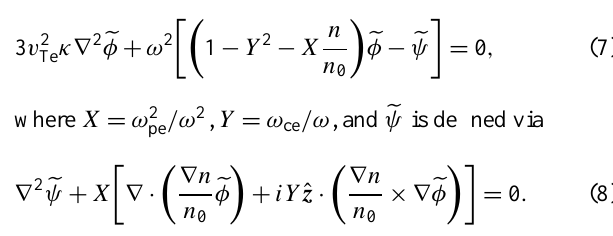
Figure 1. (a) The frequency spectrum of UH oscillations (arbi- trary units) at the center of a deep striation ( α = 0 . 1), obtained from an electrostatic simulation using a short driving pulse at the begin- ning of the simulation to excite oscillations. (b–c) : resonances indi- cated by circles, showing the eigenfrequencies ω and azimuthal- mode numbers N for (b) the coupled Eqs. (9)–(10), and (c) the Schrödinger equation (13). For each azimuthal-mode number, there exist one or more radial modes enumerated by the mode number R with R = 1 having the lowest frequency. Small azimuthal-mode numbers of N are associated with larger numbers of radial modes. The vertical dash-dotted and dashed lines indicate the local UH fre- quency at the center of and outside the striation, respectively, and vertical solid lines connect the spectral peaks in (a) with the reso- nances for N = − 1 in (b) . (d–j) : spatial profiles (arbitrary units) of the radial eigenmodes R = 1 , ..., 7 for the azimuthal-mode number N = − 1 in panel (b) for trapped UH waves. The eigenmodes have the number of extrema equal to the radial-mode number R